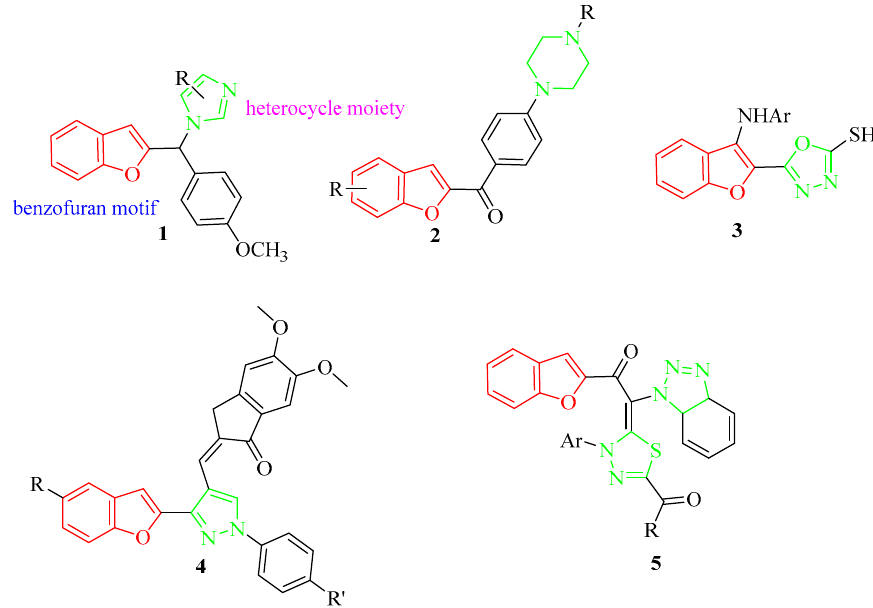
Figure 2. Chemical structures of some benzofuran-heterocycle hybrids.